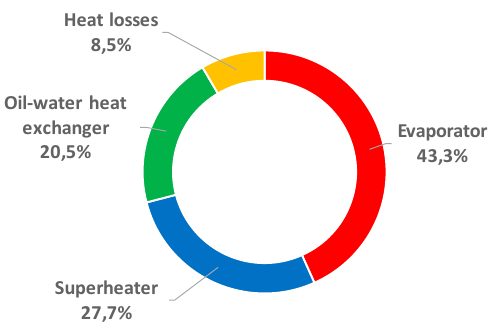
Figure 12. The percentage dissipation of the power generated in the boiler.